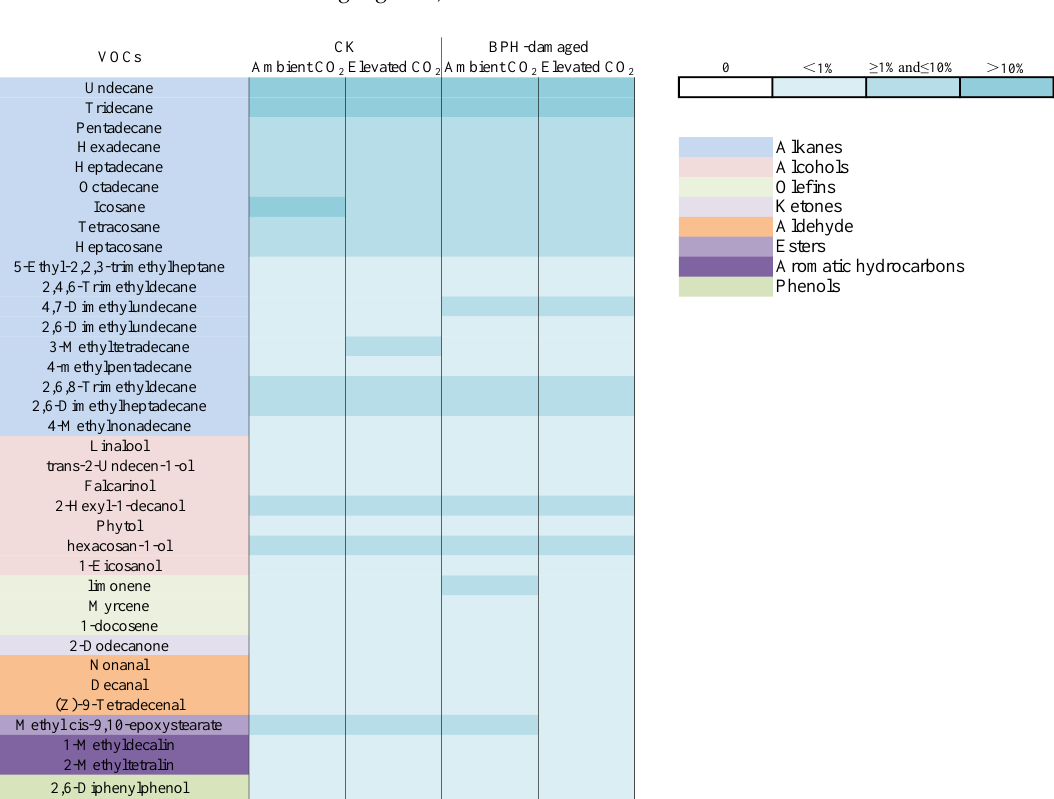
Figure 3. Percentage composition (%) of eight groups of volatile organic compounds (VOCs) from the healthy (CK) and BPH-damaged rice plants grown under ambient and elevated CO 2. ( Note : BPH -Brown planthopper, Nilaparvata lugens ; Different uppercase and lowercase letters indicate significant differences between ambient and elevated CO 2 level, and between the healthy (CK) and BPH-damaged rice plants by the independent sample t -test at p < 0.05, respectively. The same is true in the following Figure 4).